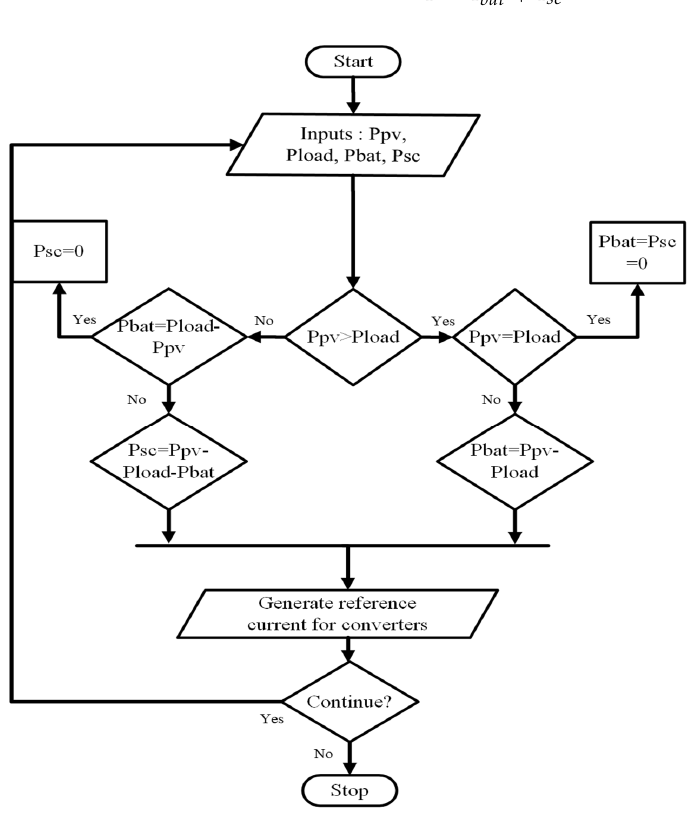
Figure 5. Power management strategy of the DC bus control.